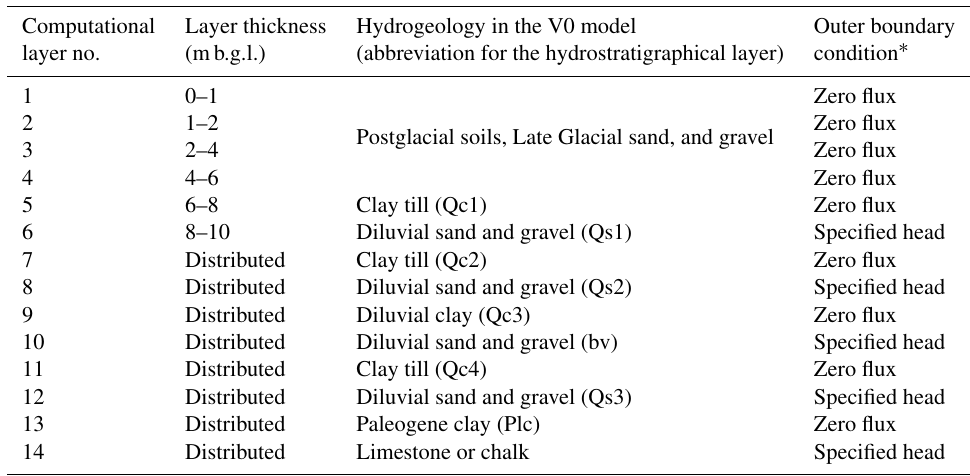
Table 3. Conditions for the computational layers in the hydrological models. Computational Layer thickness Hydrogeology in the V0 model Outer boundary layer no. (mb.g.l.) (abbreviation for the hydrostratigraphical